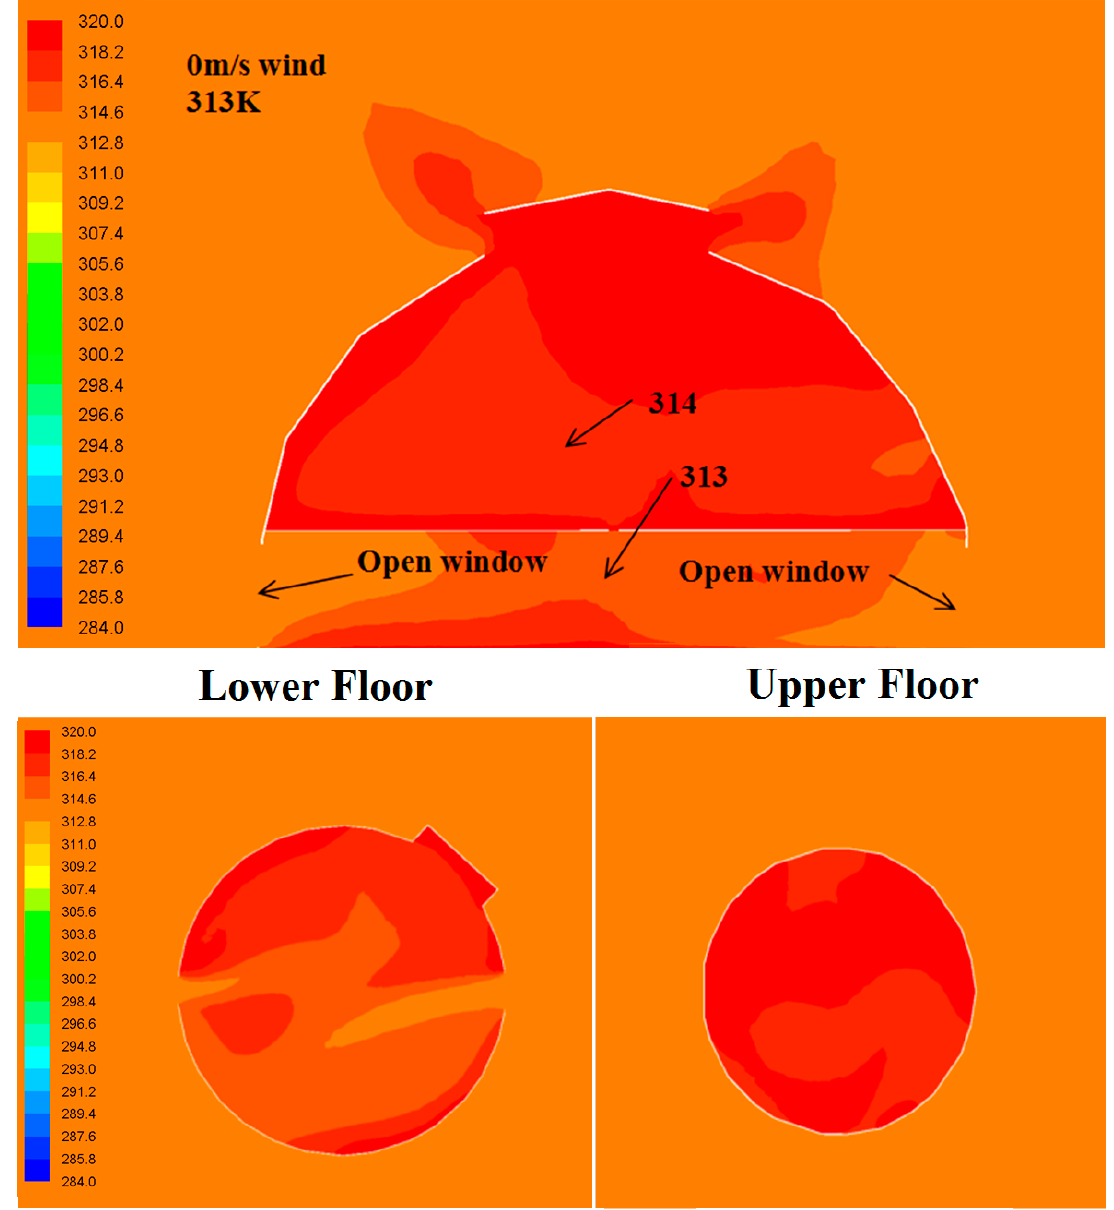
Figure 17. Comparison of the airflow speed distribution inside the dome house during winter and summer (buoyancy-induced flows).